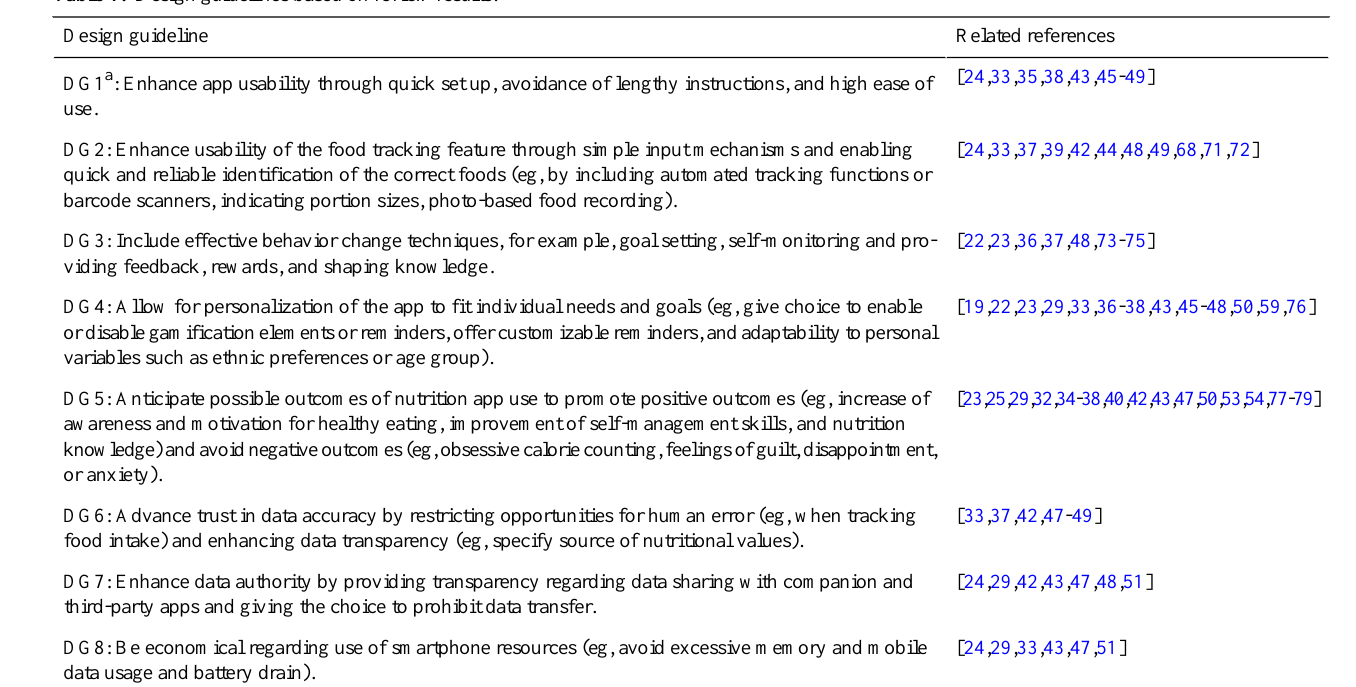
Table 1. Design guidelines based on review